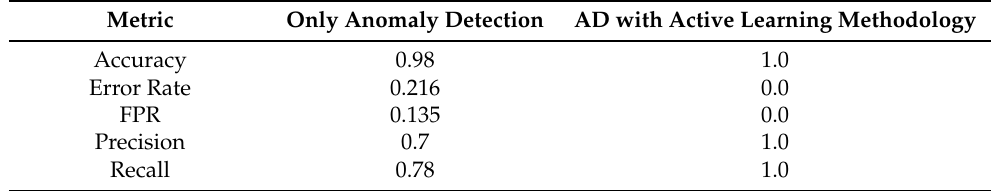
Table 2. Anomaly Detection vs. Active Learning